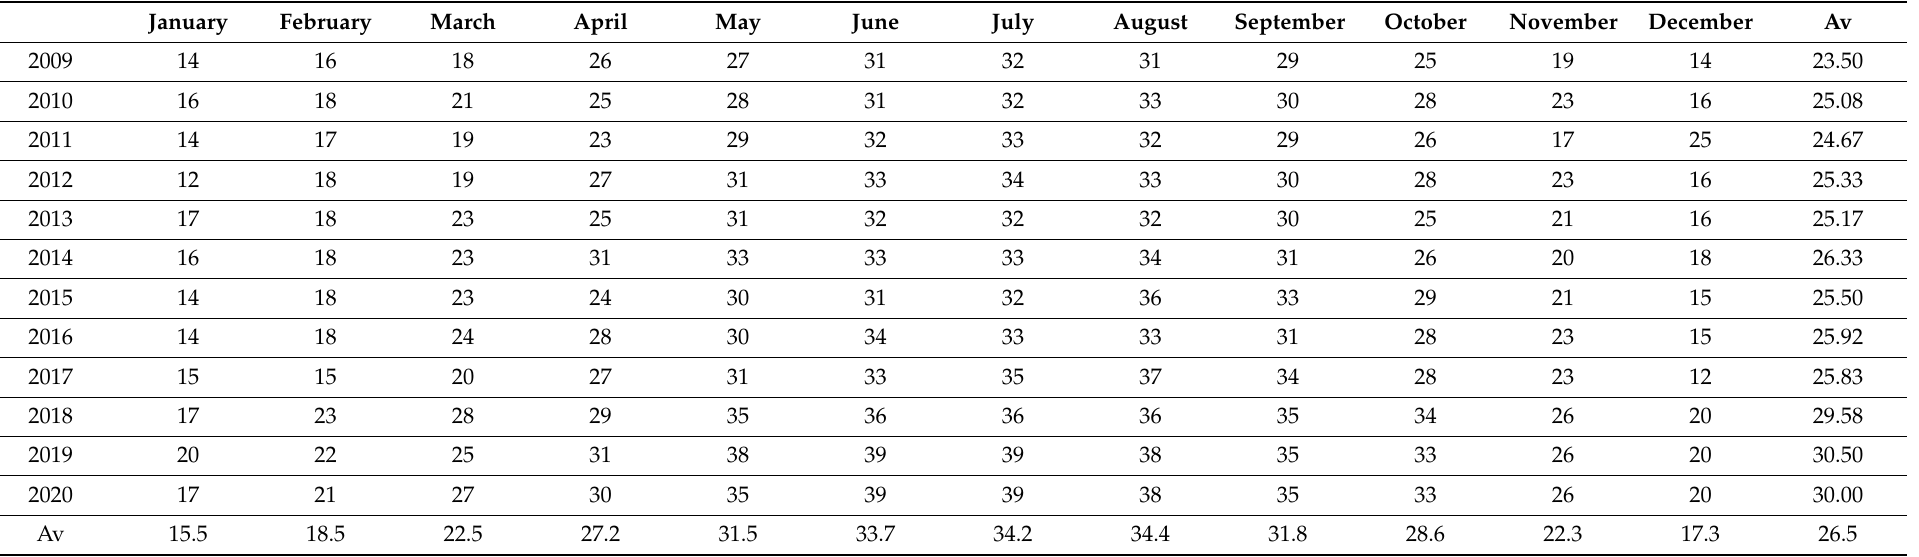
Table 1. Monthly temperature ( ◦ C) at Lake Nasser during the period from 2009 to